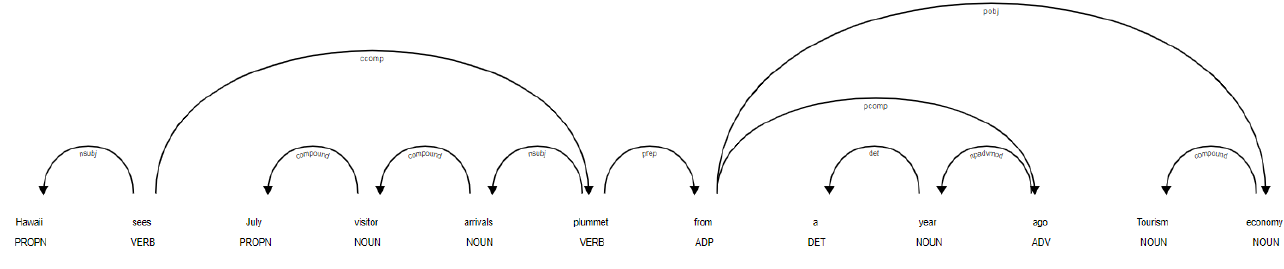
Figure 13. Sentence Parsing. Table 3. Sentence Parsing.